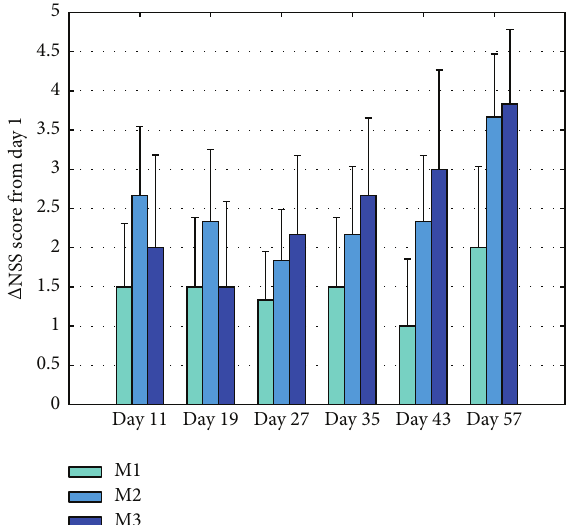
Figure 2: Modified Neurological Severity Scale. Modified Neuro- logical Severity Score was tested in 15 animals at days 1, 11, 19, 27, 35, 43, and 57. M1 group received sham treatment, M2 was exposed to 3.93 Hz, and M3 was exposed to 15.72 Hz VLIFE 2 min sessions, in alternate days, for a month and followed up for an additional month. Values are mean ± SE of the difference from day 1; 𝑝 = 0.002 for M2 and 𝑝 = 0.02 for